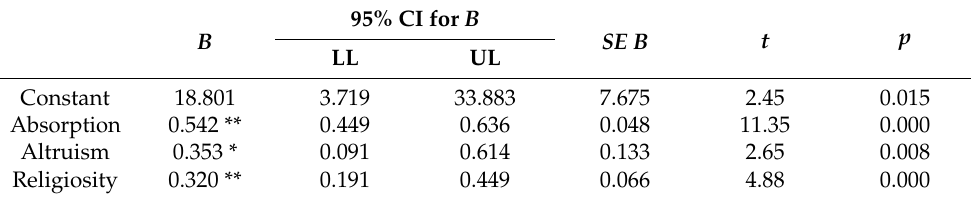
Table 1. Regression results for mystical experience